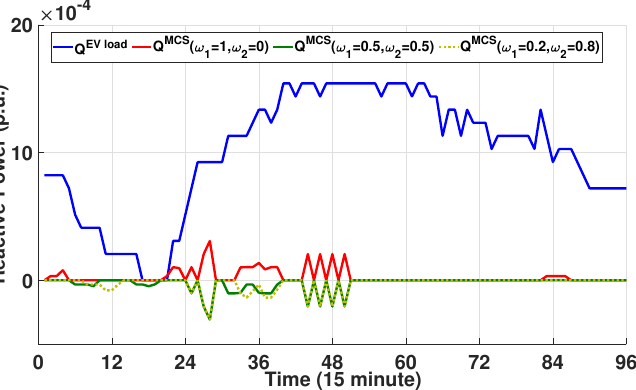
Figure 10. Reactive power consumption schedule for EVs and MCSs with different